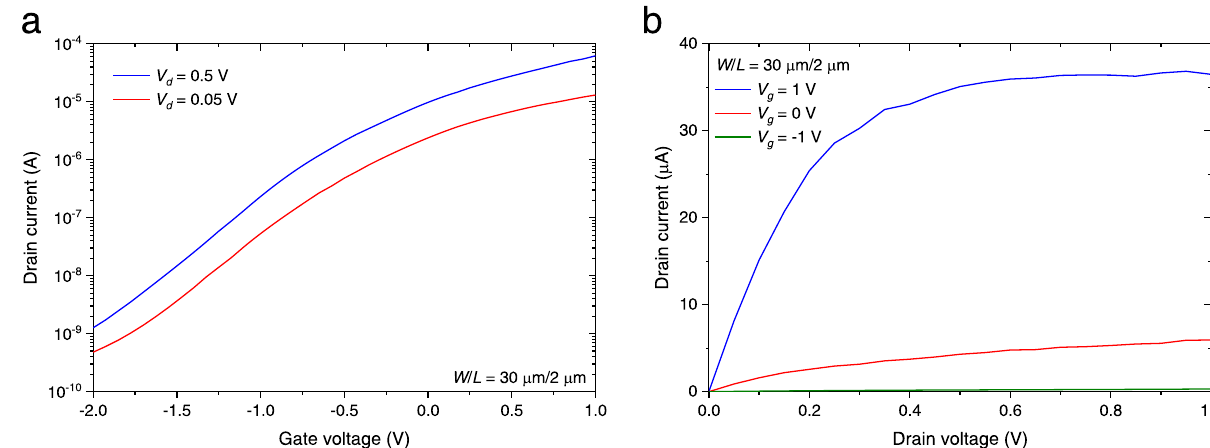
Fig. 2 | Electrical characteristics of a waveguide-coupled InGaAs phototransistor with no light injection. a I d – V g characteristics with V d of 0.05V and 0.5V. b I d – V d characteristics with V g of − 1V, 0V, and 1V.